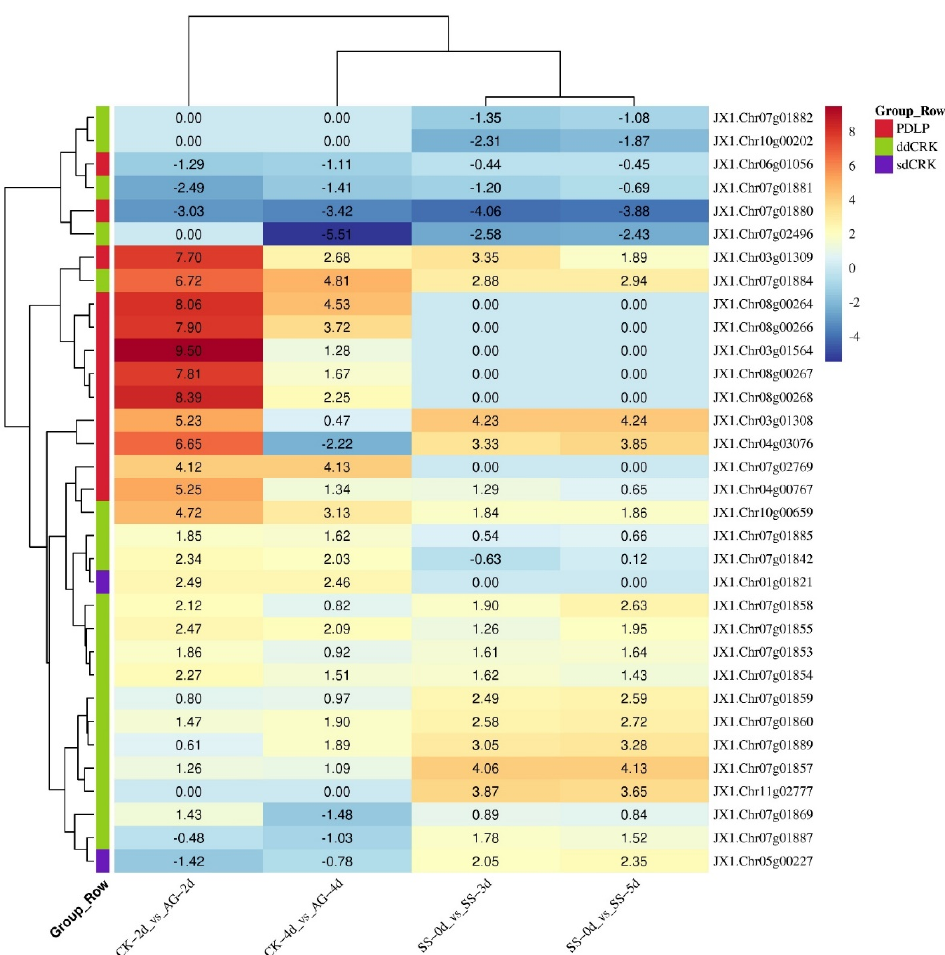
Figure 4. The expression profile of the DUF26 domain-containing genes after different periods of submergence, in which AG is anaerobic germination, SS is seedling submergence, and CK is normal growth. The heatmap was generated by taking log2 fold of the FPKM